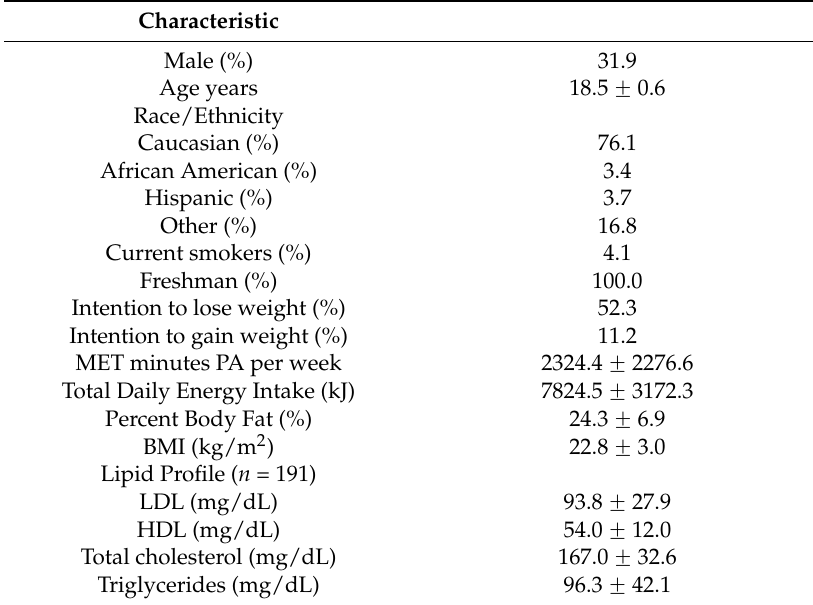
Table 1. Overall sample characteristics ( n =